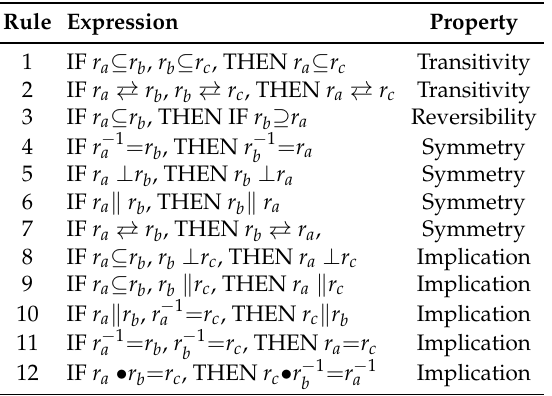
Table 3. Reasoning rules based on entity